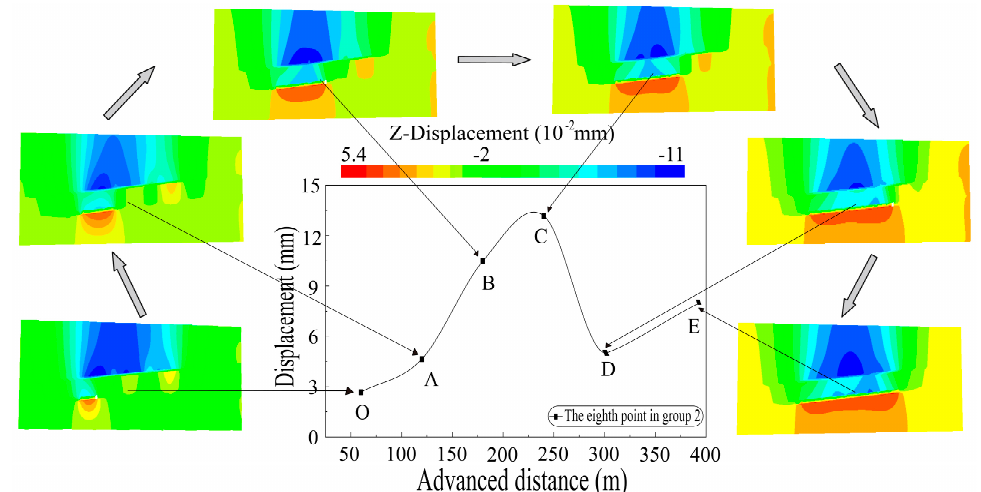
Figure 8. The change law of the displacement over the process of backfilling mining.